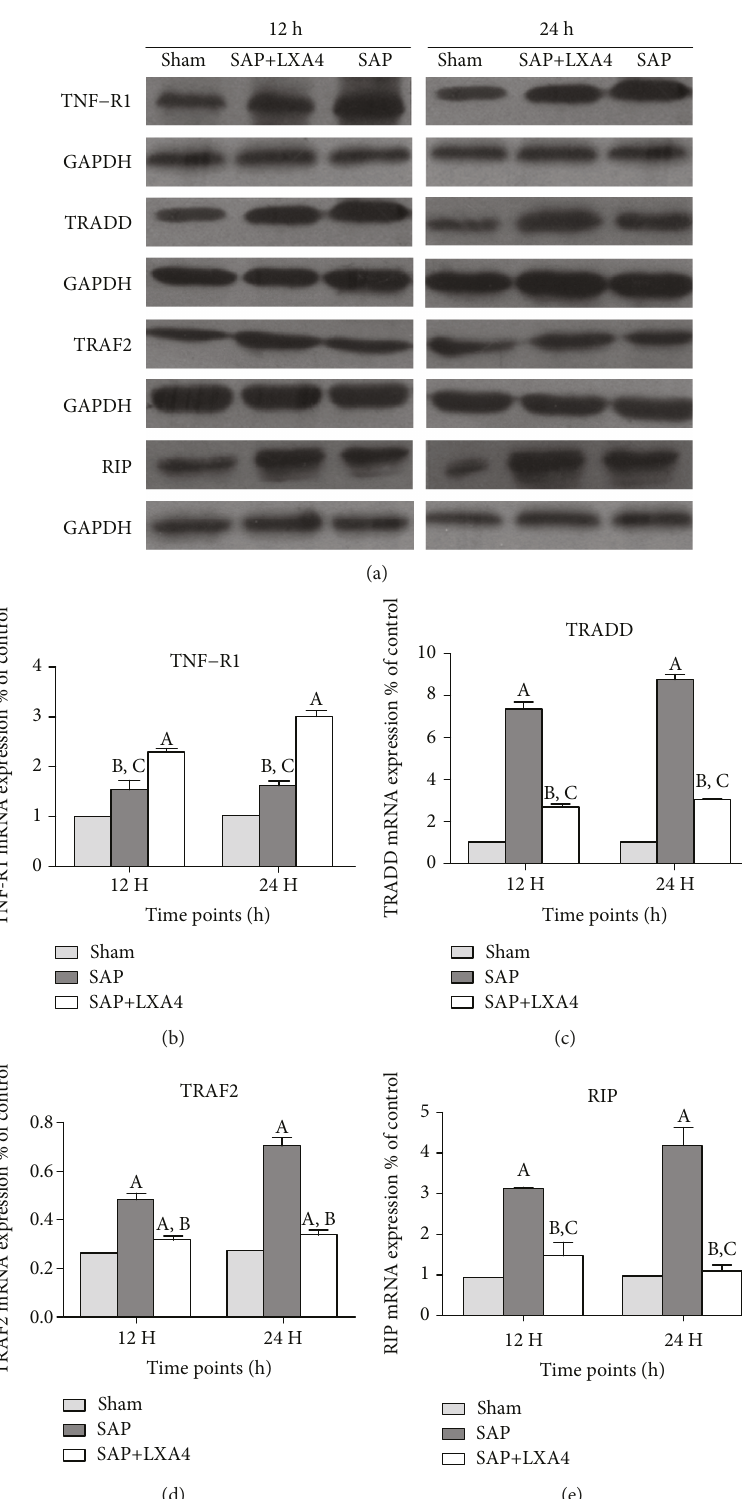
Figure 6: Downregulation of TNF- α /TNF-R1 signal in lung tissues by AT-Lipoxin A4 administration. (a – e) Western blot assay shows expressions of total TNF-R1, TRADD, TRAF2, and RIP in lung tissue at 12h or 24h after the procedure. GAPDH was used as an internal control. Data represent the mean ± SEM ( n = 8 ). (A) P < 0 05 , SAP vs. sham; (B) P < 0 05 , SAP+AT-Lipoxin A4 vs. sham; (C) P < 0 05 SAP+AT-Lipoxin A4 vs.